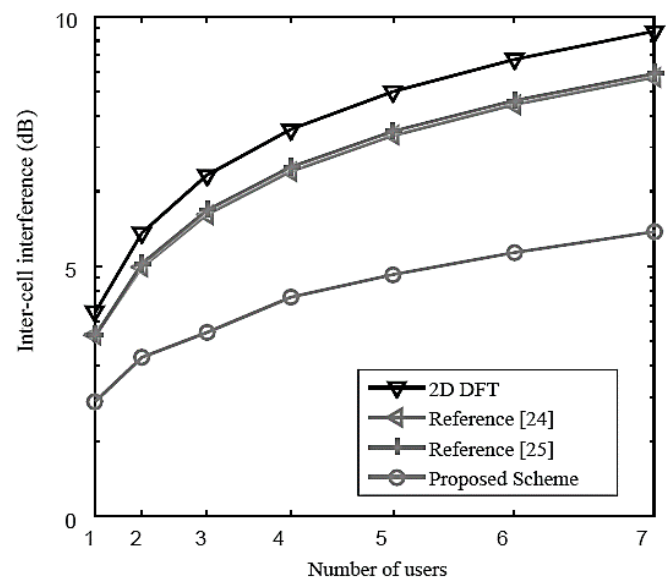
Figure 11. Comparison of the inter-cell interference versus a number of users for the proposed 3D codebook and other state-of-the-art schemes.